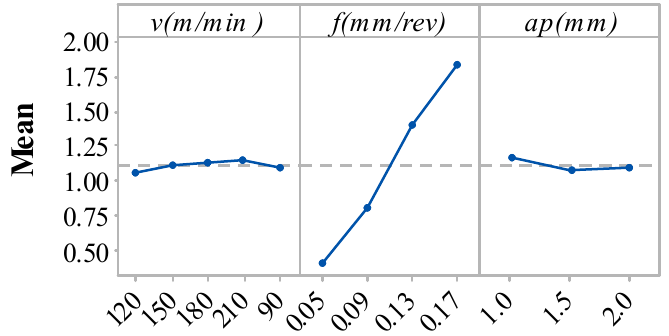
Table 7. Values of partial solutions.